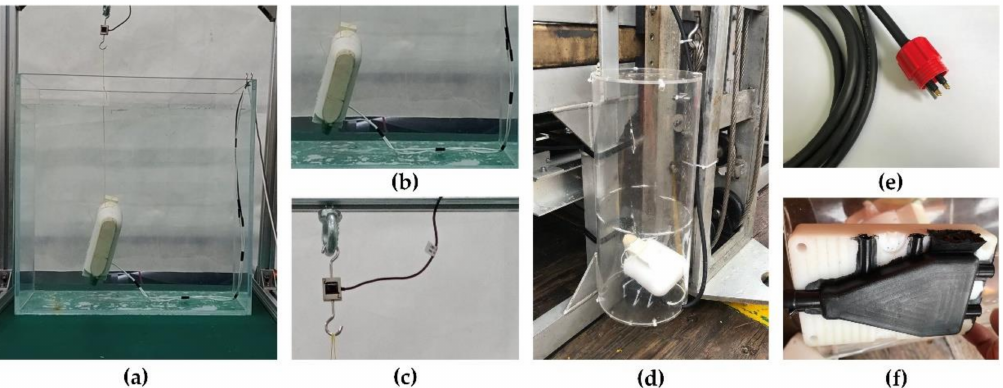
Figure 8. Experimental design and installation details for the rise and levitation tests: ( a ) experimental layout in the flume (0 MPa); ( b ) power supply wire; ( c ) force sensor (real-time monitoring of net buoyancy when net buoyancy is less than 0); ( d ) the installation position of the buoyancy adjustment device on the Seahorse; ( e ) deep-sea cable watertight joint; ( f ) curing treatment of deep-sea cable watertight